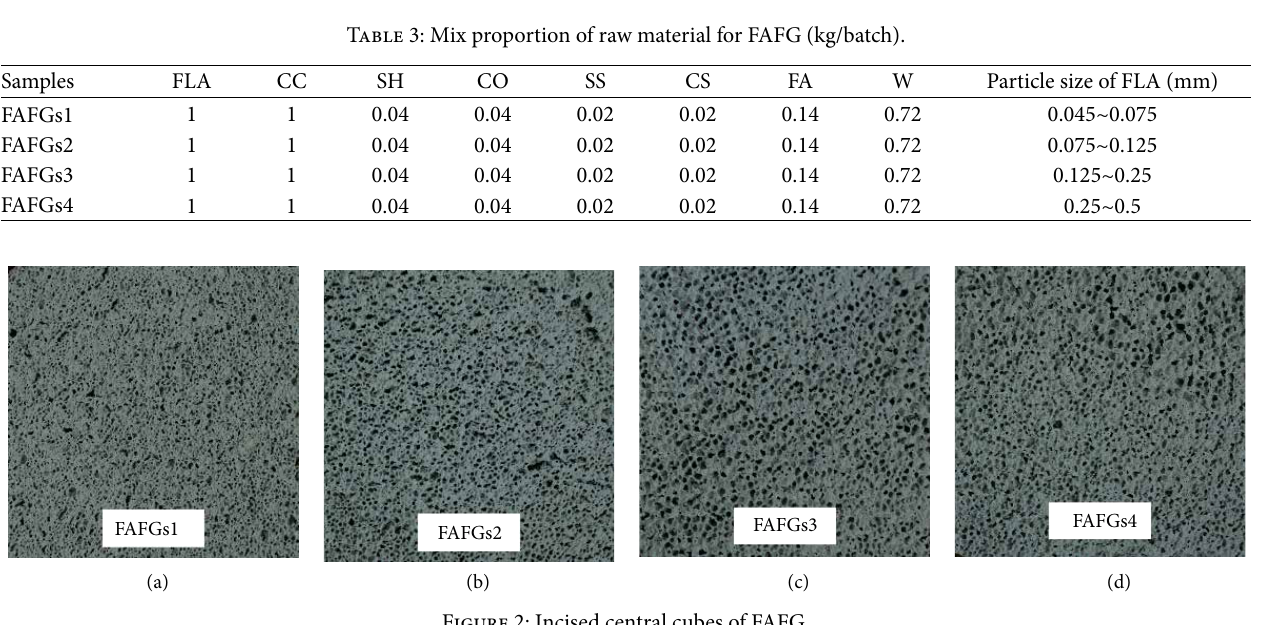
Figure 2: Incised central cubes of